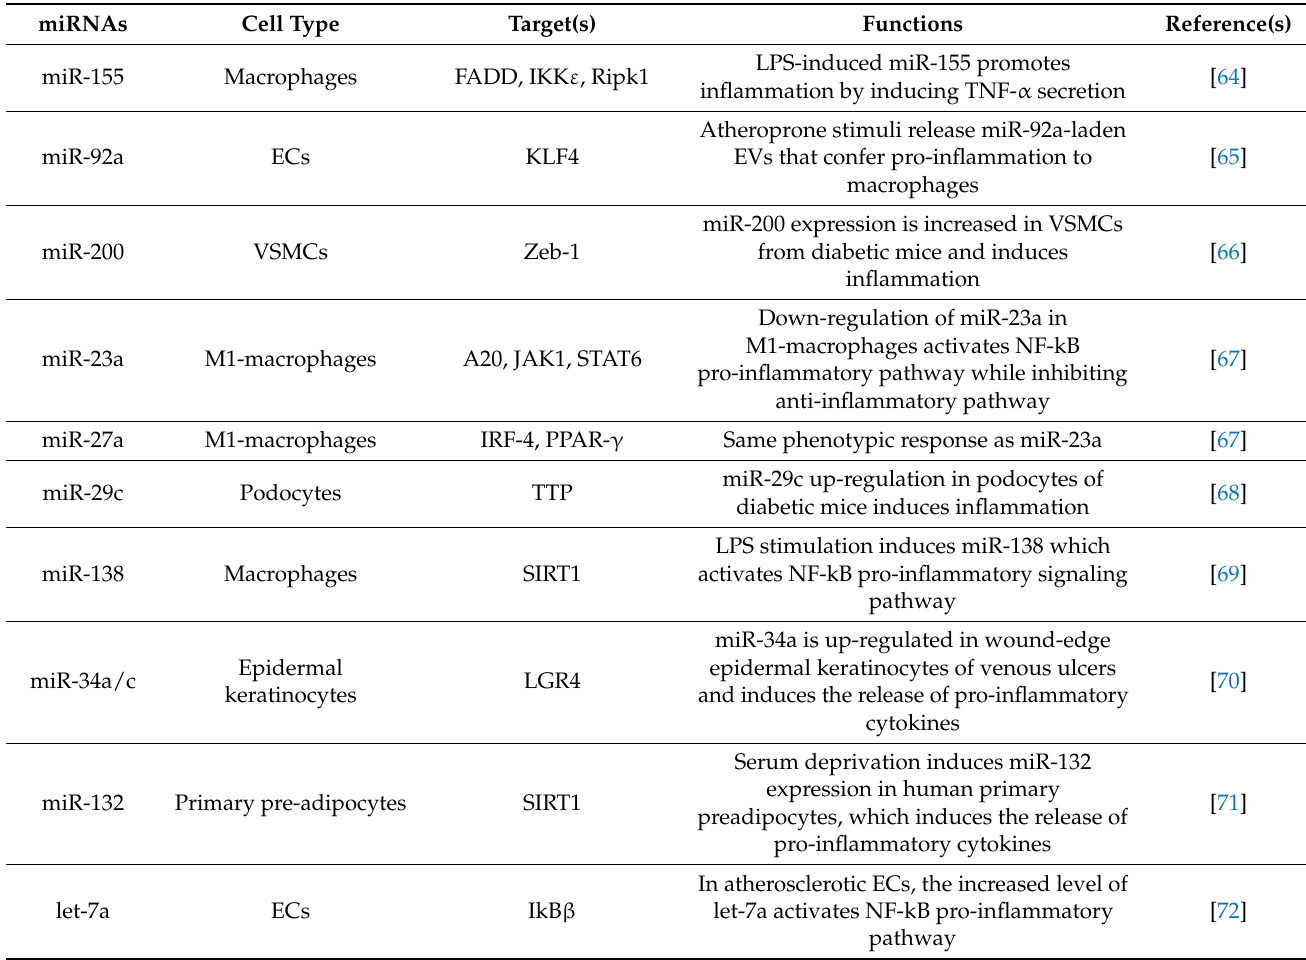
Table 1. Pro-inflammatory miRNAs and their targets and functions.